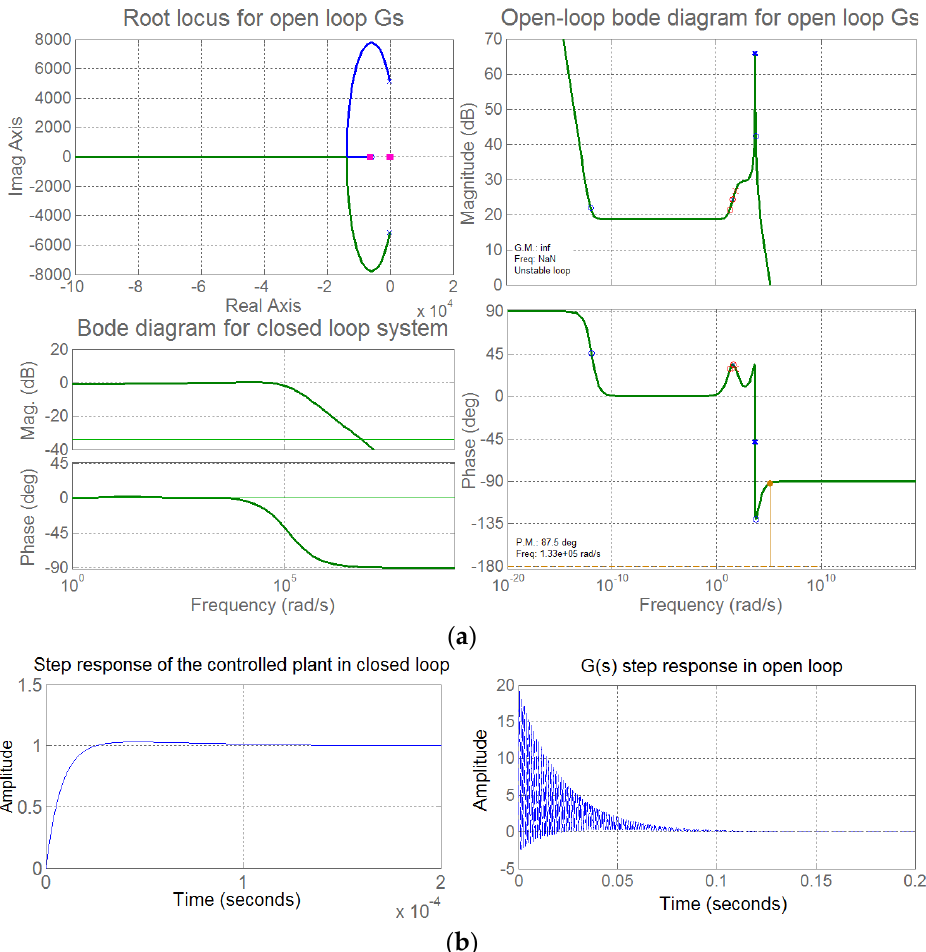
Figure 4. ( a ) Root locus for open-loop and Bode diagrams. ( b ) Uncontrolled (open loop) and controlled (closed loop) G(s) step responses of plant.